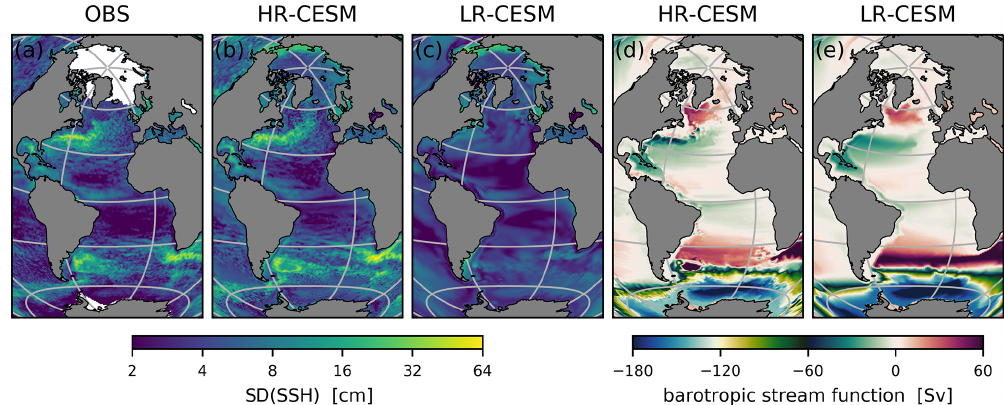
Figure 4. (a) The standard deviation of the observed sea surface height anomalies on a 1 / 6 ◦ grid (Zlotnicki et al., 2019). Missing data are white. (c, d) The dynamic sea level standard deviation of the HR- and LR-CESM CTRL simulations. (d, e) The mean barotropic streamfunction (cid:57) of the HR- and LR-CESM CTRL simulations relative to the African Atlantic